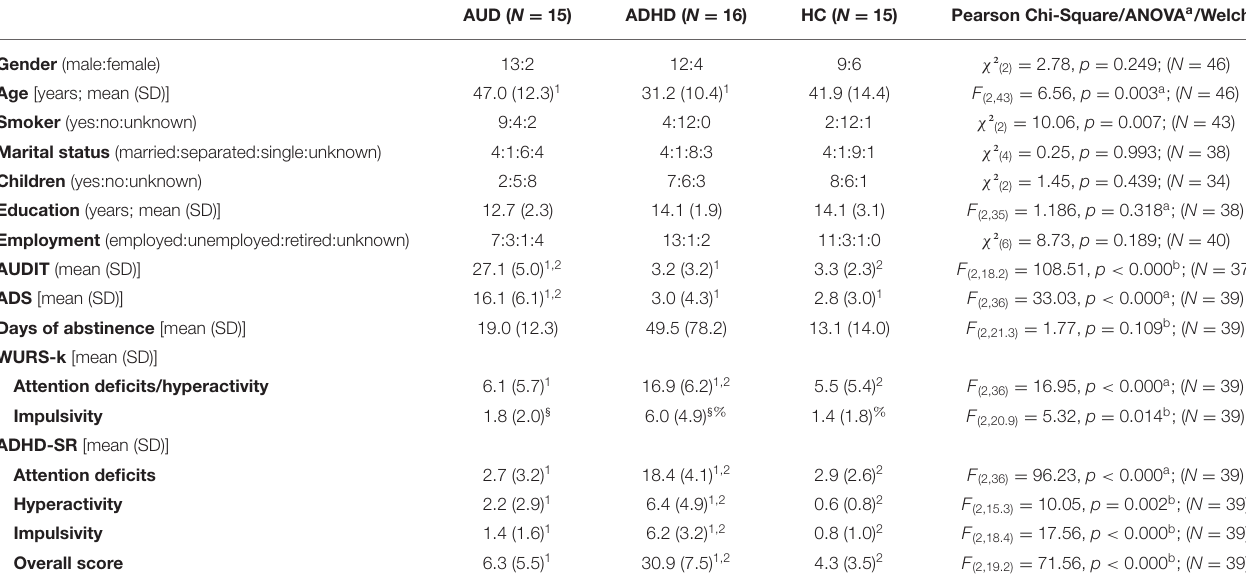
TABLE 1 | Group characteristics of all participants including corresponding statistics. AUD ( N = 15) ADHD ( N = 16) HC ( N = 15) Pearson Chi-Square/ANOVA a /Welch b